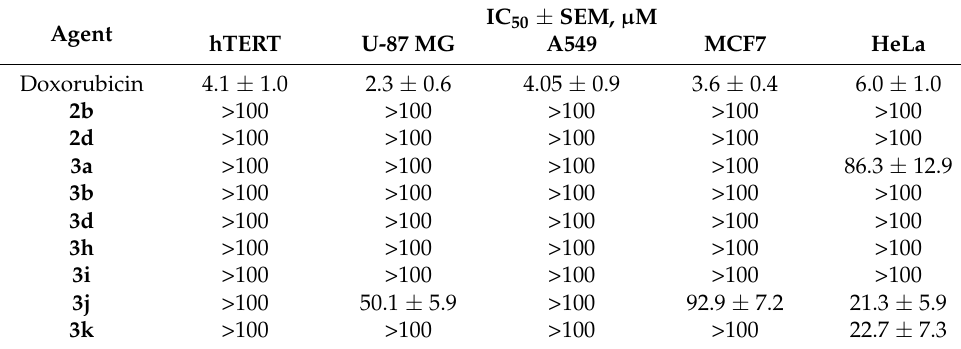
Table 2. Cytotoxicity of quinolinones versus